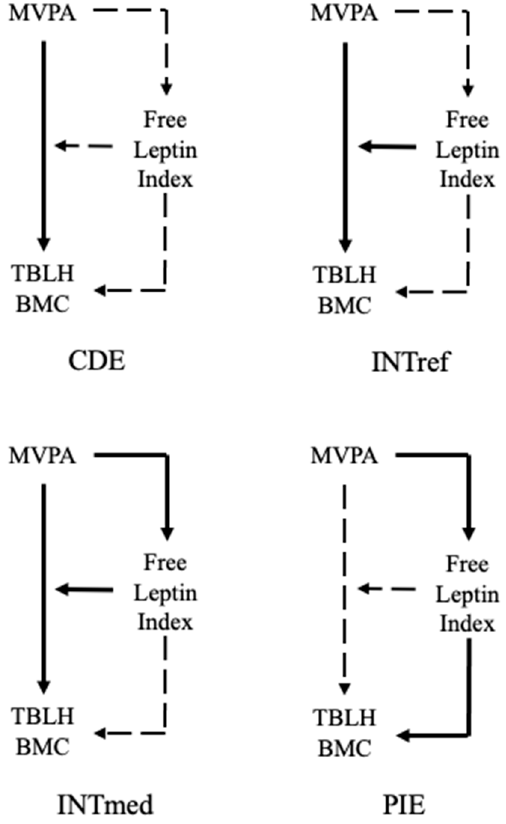
Figure 2. The components of the 4-way decomposition analysis as described by VanderWeele [13]. Controlled direct effect, CDE; reference interaction, INTref; mediated interaction, INTmed; pure indirect effect, PIE; moderate-to-vigorous physical activity, MVPA; total body less head bone mineral content; TBLH BMC. Solid lines show the pathway for the effect of interest while dashed lines show effects held constant.